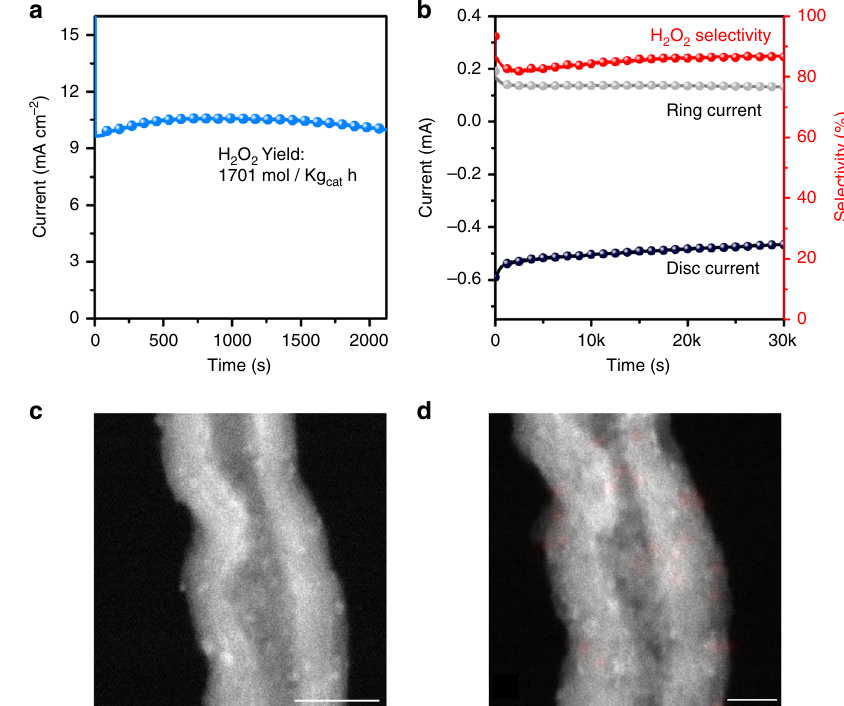
Fig. 4 Yield and stability of H 2 O 2 electrocatalysts in the acid electrolyte. a Chronoamperometry curve of Pd δ + -OCNT in the H-cell test at 0.1 V. b Stability test of Pd δ + -OCNT in a O 2 -saturated 0.1 M HClO 4 at 0.1 V. All the experiments were performed at 25 o C. ADF-STEM image c and its corresponding EDS element mapping d of Pd δ + -OCNT after the stability test (scale bar: c 10 nm and d 5